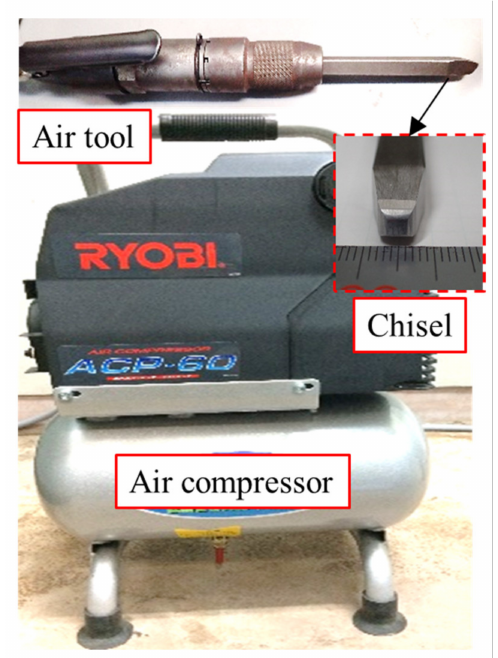
Figure 2. The hammer peening equipment.